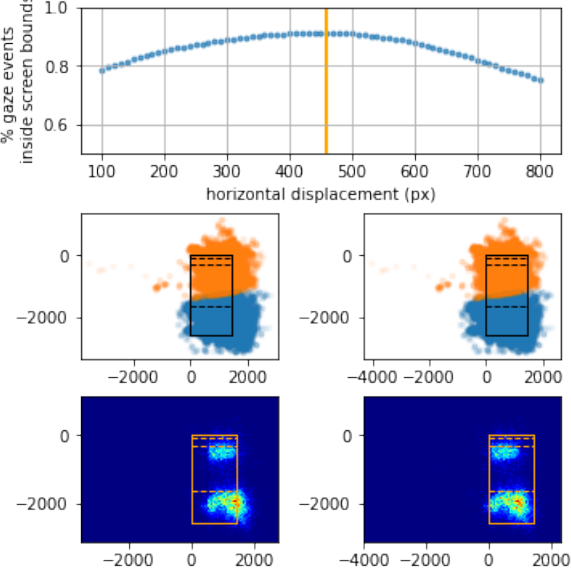
Figure 3. Percentage of gaze data within device boundaries after shifting at each linear step ( top ). The orange line shows optimal shifting at 460 px to the left. Results of the shifting at the opti- mal point are shown with raw gaze points and 2D-histogram visualisations ( left : original data, right : after shift).